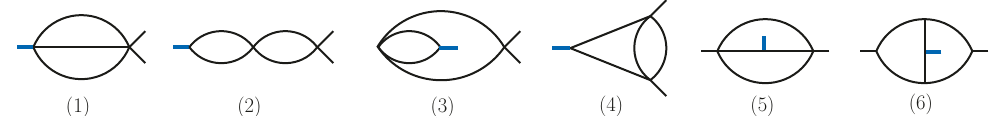
Figure 2 . The master integrals of the 2-loop 2-point form